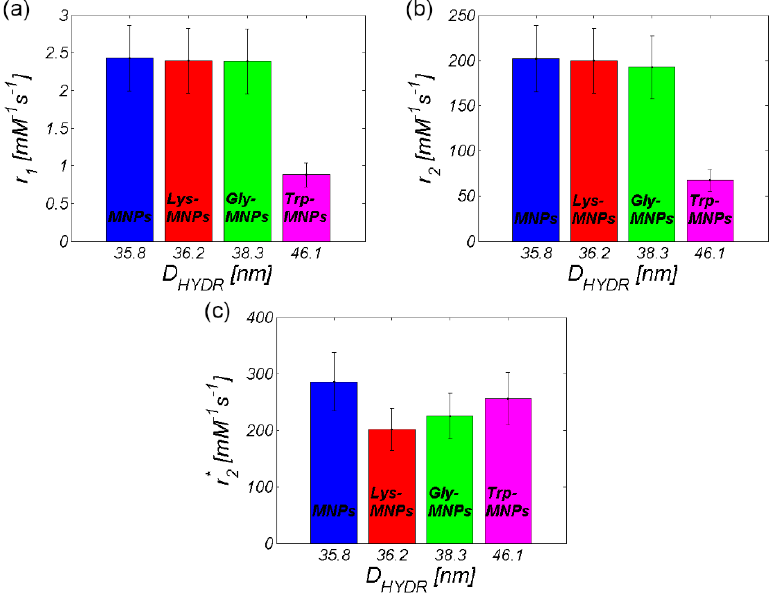
Figure 12. Relaxivity of the AA–MNP complexes depending on hydrodynamic diameter ( a ) r 1 , ( b ) r 2 , and ( c ) r 2